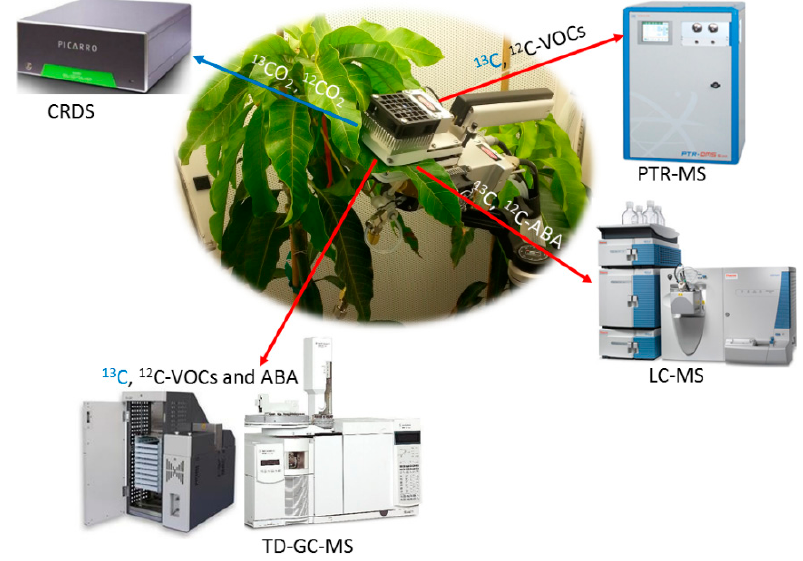
Figure 6. Example of a potential experimental instrumentation configuration for the quantification of 13 C-labeling analysis of volatile isoprenoids (isoprene and monoterpenes) and non-volatile isoprenoids (e.g., ABA and carotenoids) during photosynthesis under a 13 CO 2 atmosphere. The blue arrow represents stable carbon isotope analysis of CO 2 by laser spectroscopy and the red arrows represents stable carbon isotope analyses of ABA and volatile organic compounds (VOCs) by mass spectrometry.